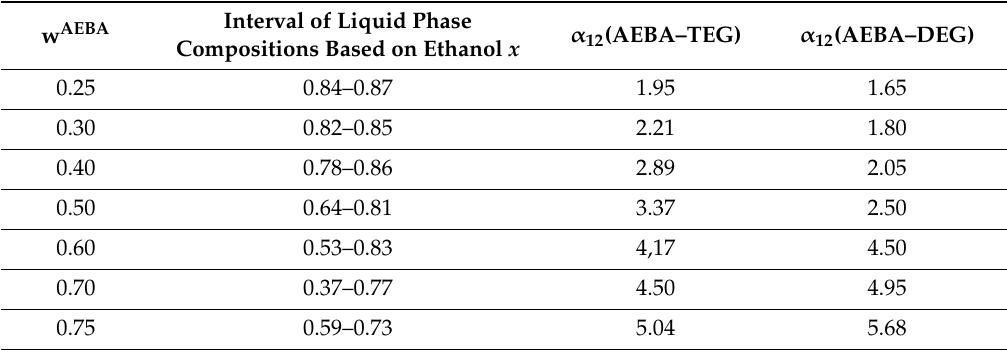
Table3. Coe ffi cientofrelativevolatilityofethanoldependingonAEBA–DEG / AEBA–TEGconcentration. Interval of Liquid Phase w AEBA Compositions Based on Ethanol Table 3. Coefficient of relative volatility of ethanol depending on AEBA–DEG/AEBA–TEG concentration.